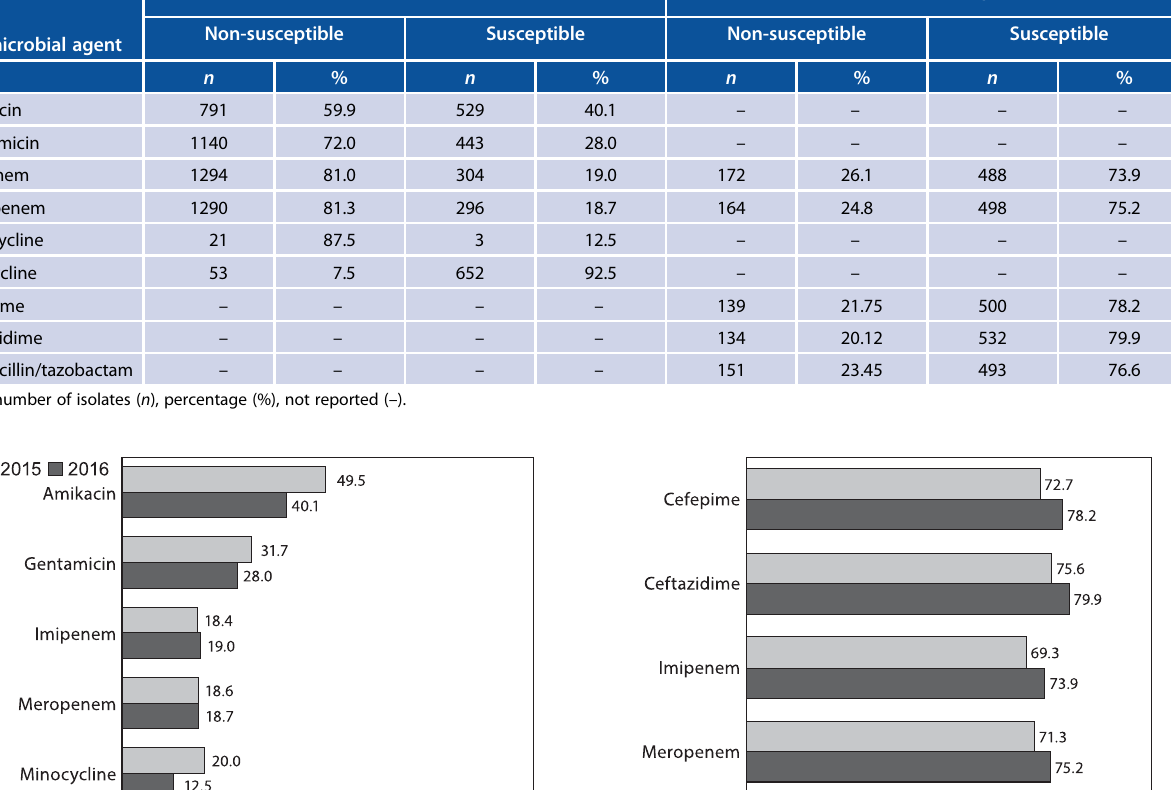
Antimicrobial agent